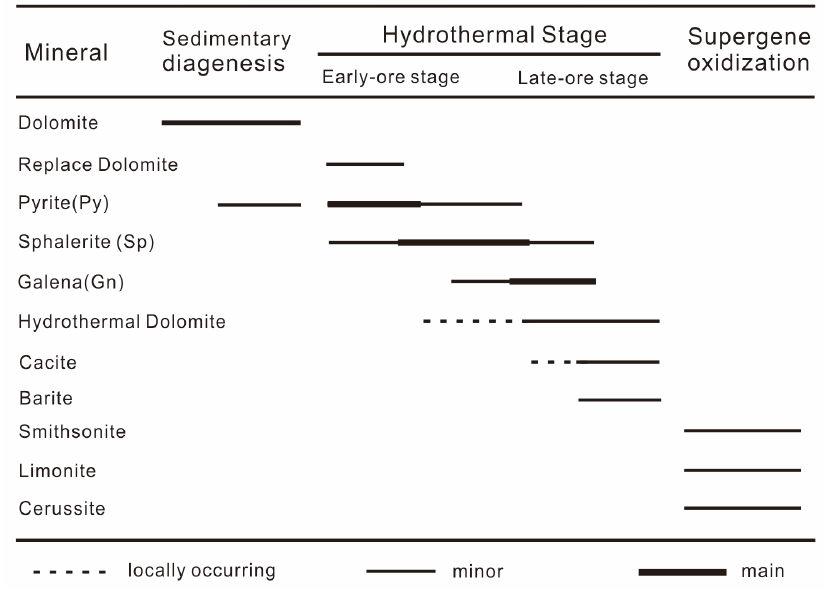
Figure 6. Mineral paragenesis in the Nayongzhi deposit.